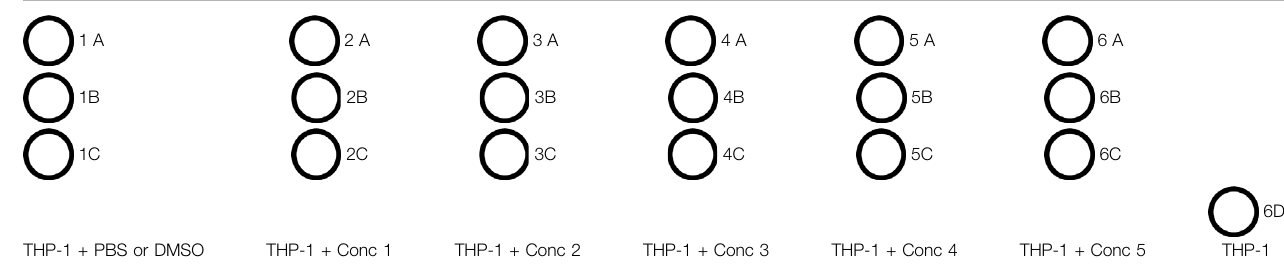
TABLE 5 | Example of tubes setup.